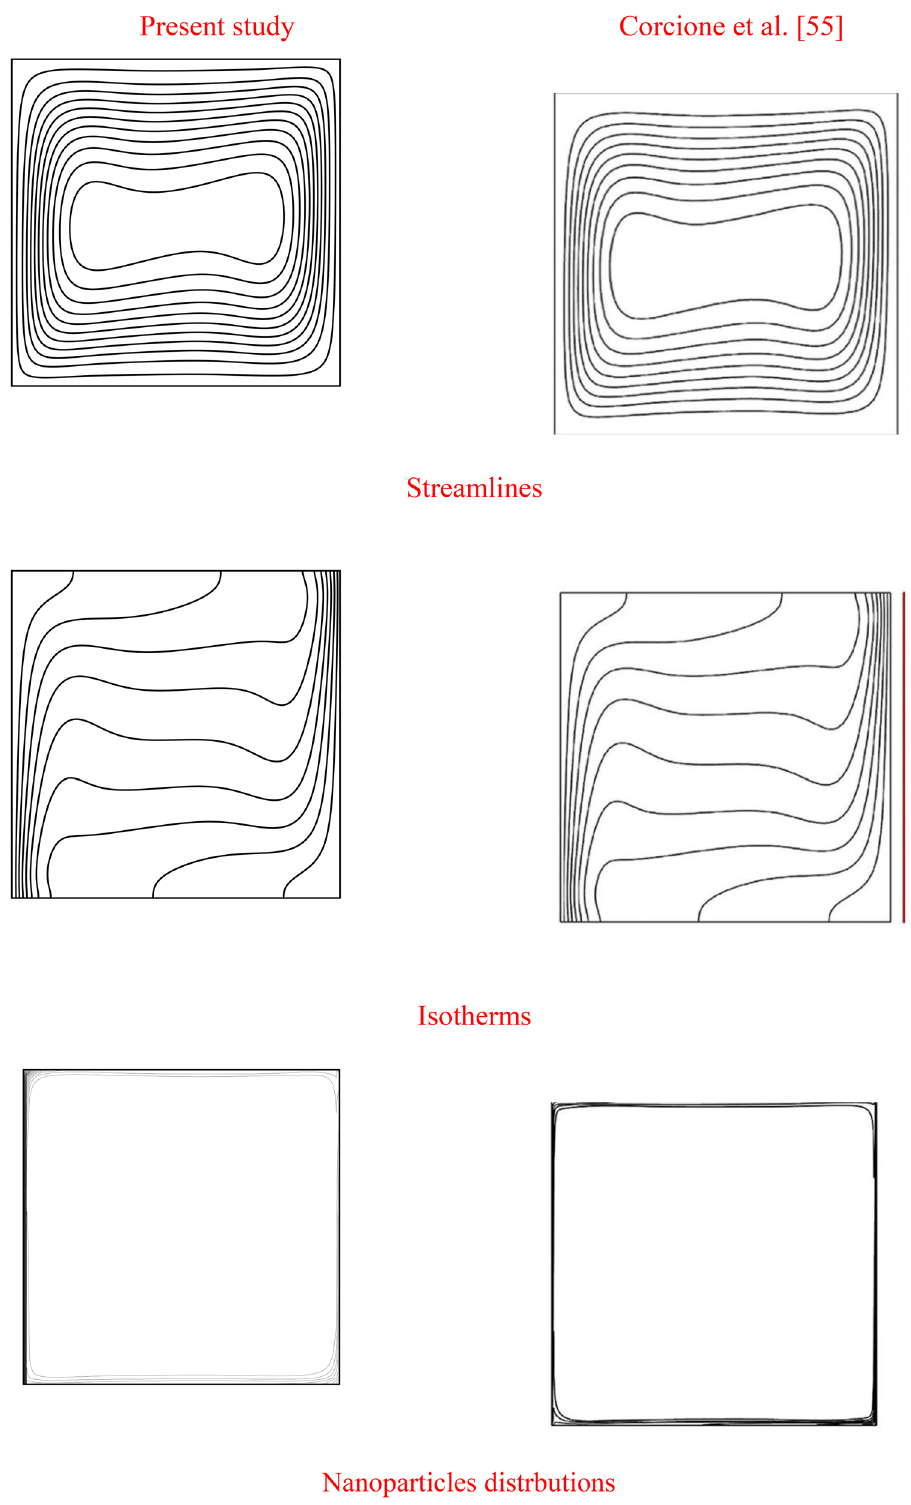
3.37 10 5 and φ 0.04 = × =